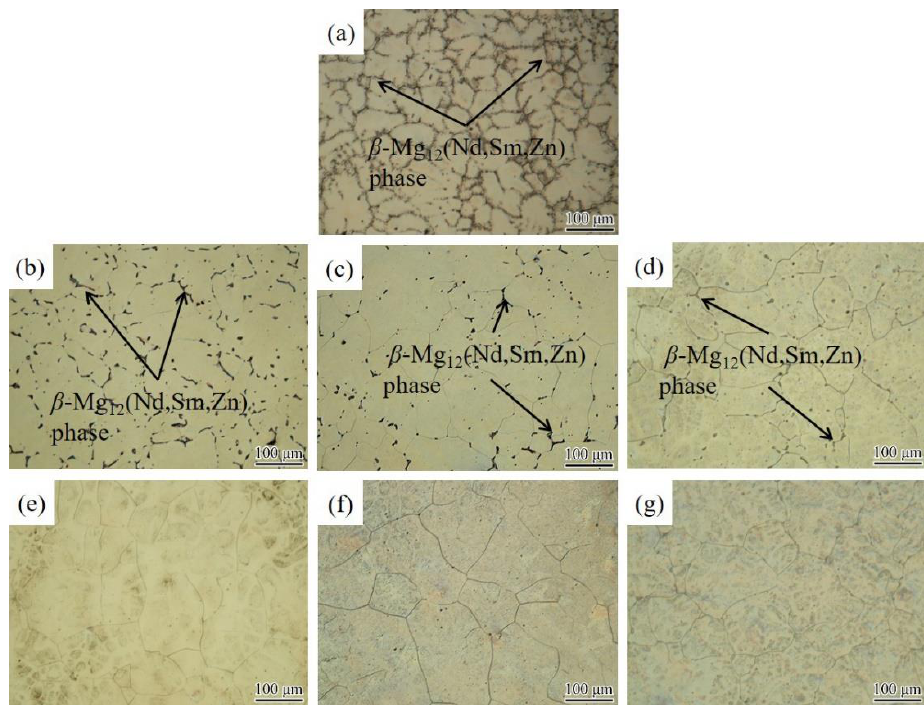
Figure 1. Optical images of Mg-2.0Nd-2.0Sm-0.4Zn-0.4Zr alloy. ( a ) as-cast alloy; the solution-treated alloys at 788 K for ( b ) 2 h, ( c ) 4 h, ( d ) 6 h, ( e ) 8 h, ( f ) 10 h and ( g ) 12